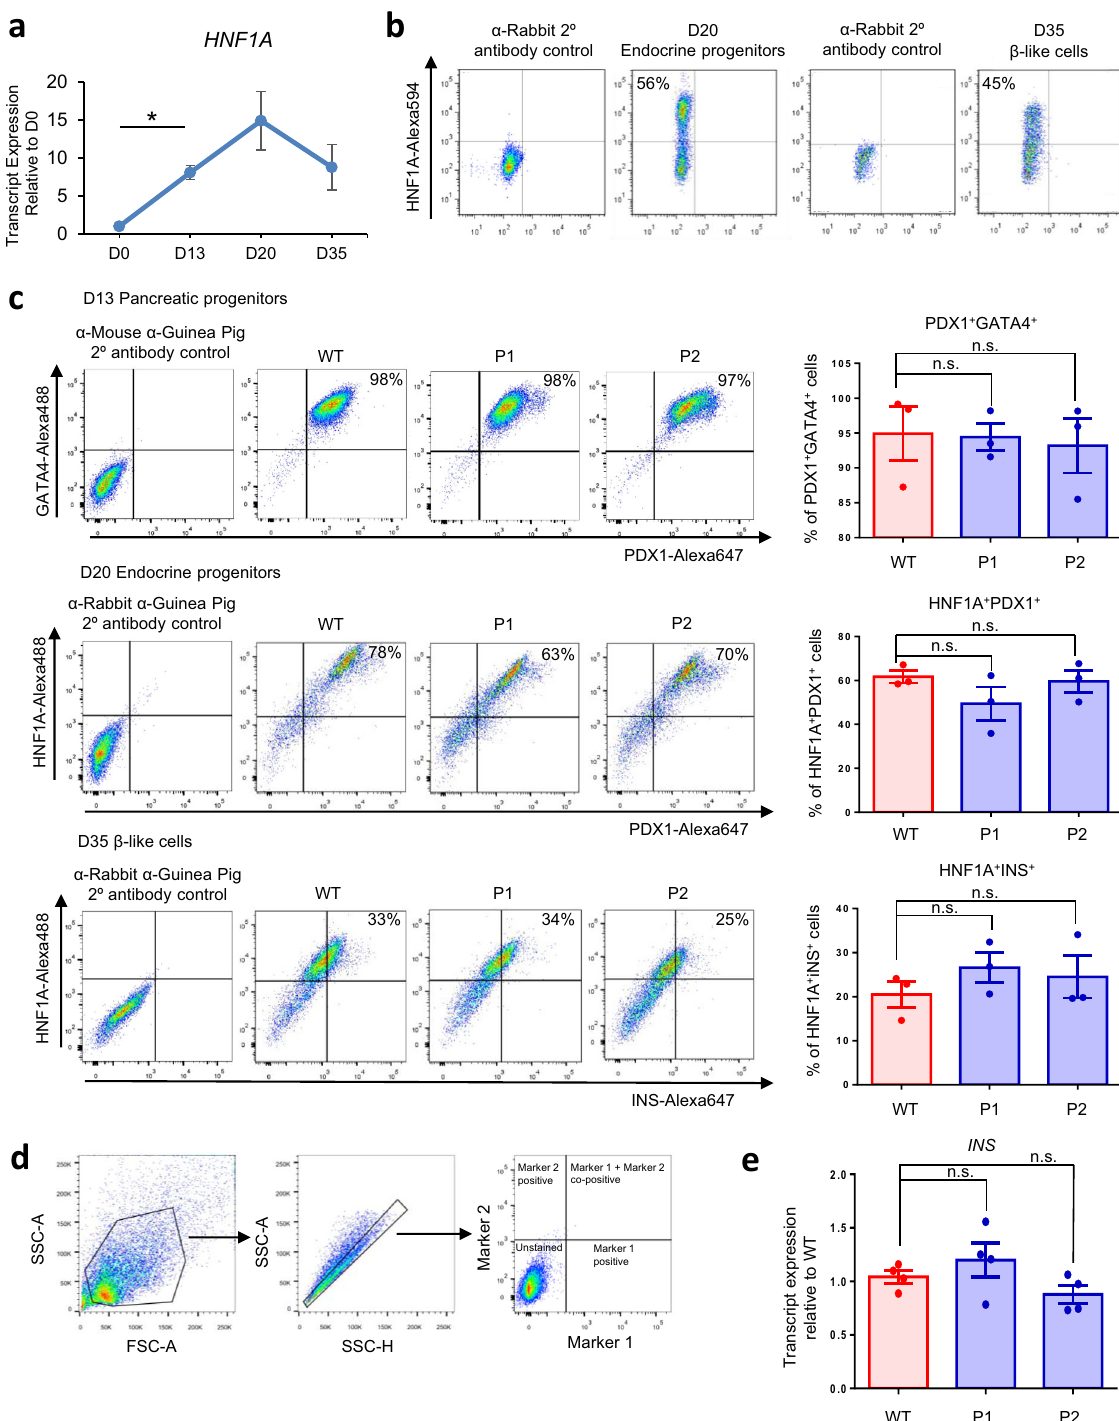
identi fi ed in the triple overlap in the transcriptomics data for HNF1A + /H126D endocrine progenitors, HNF1A + /T260M islets and HNF1A + / − hESC-derived β cells (Fig.